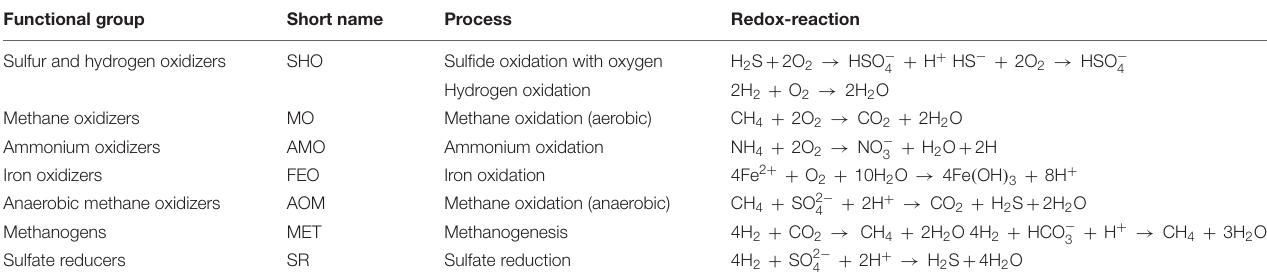
TABLE 2 | Overview of chemical processes and definition of functional groups according to redox-reactions used as energy